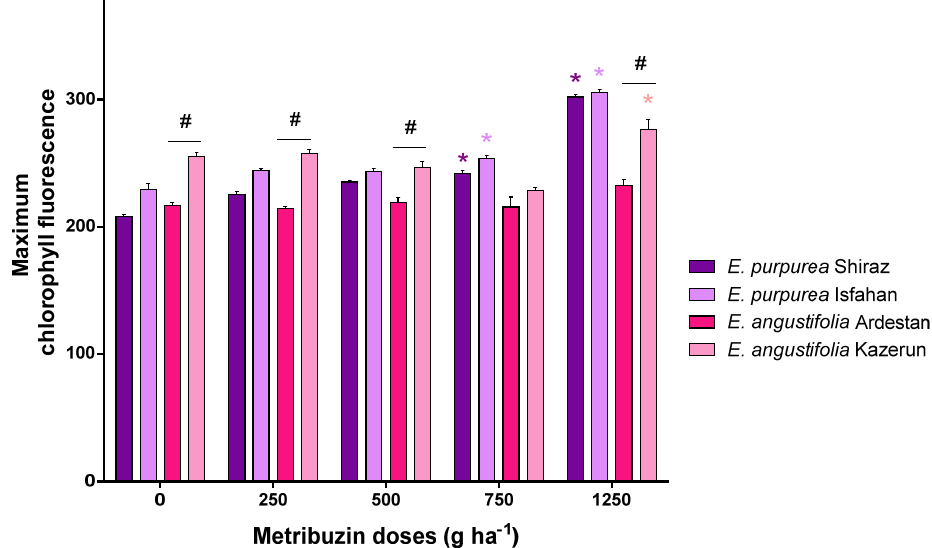
Figure 8. Effect of different metribuzin doses on maximum chlorophyll fluorescence of Echinacea purpurea and Echinacea angustifolia species. Data are shown as the mean ± SEM, and ordinary two-way ANOVA followed by Dunnett’s multiple comparisons test was used for statistical significance; * p < 0.005 vs. control (0 g ha − 1 metribuzin). Significant differences between Echinacea cultivars are indicated with